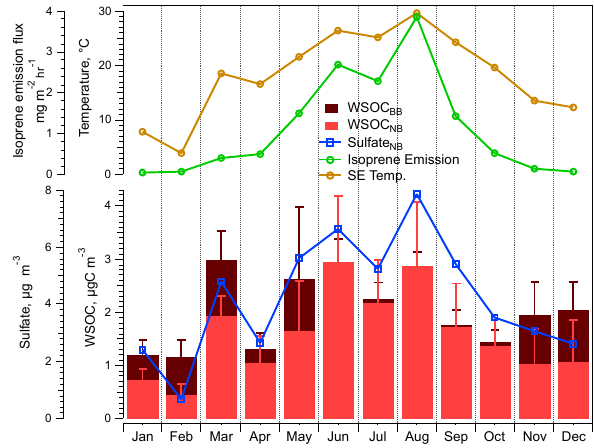
Fig. 4. Monthly mean concentrations of WSOC BB and WSOC NB , sulfate and temperature averaged over all sampling sites; regional average isoprene emission flux over the sampling domain (30– 36 ◦ N, 80–89 ◦